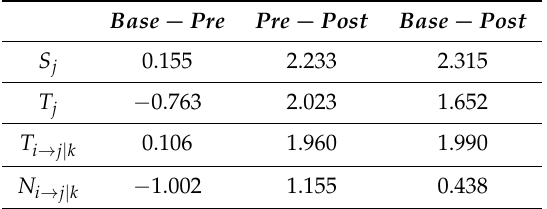
Figure 8. Information dynamics of source EEG signals measured during focal seizures. Plots and symbols are as in Figure 7. Table 4. Cohen’s d effect size—Generalized seizures—Source signals.